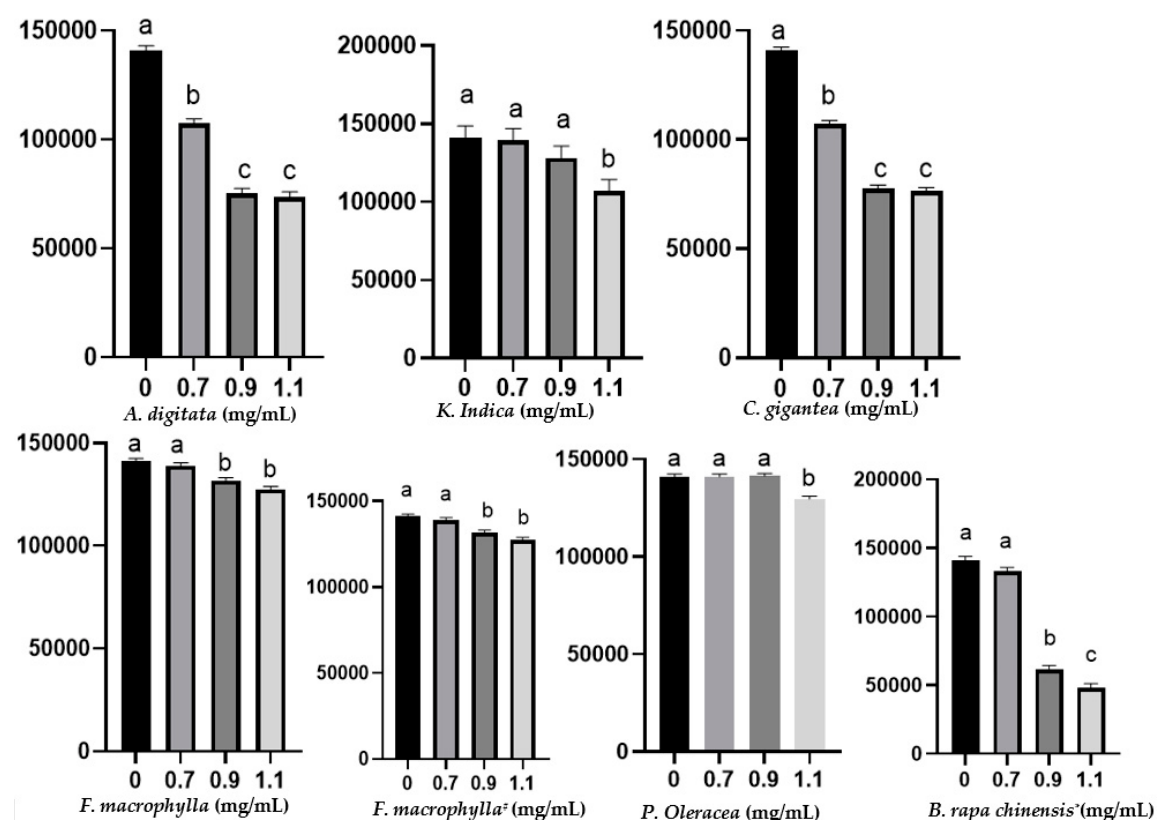
Figure 2. Total rumen protozoa count after 24 h of in vitro incubation at different doses of each plant. The Y-axis represents the total number of protozoa cells per mL of culture fluid. Different superscripts on the bars within each graph denote significant difference ( p < 0.05) among plant doses. *Roots were used; #tubers were used.